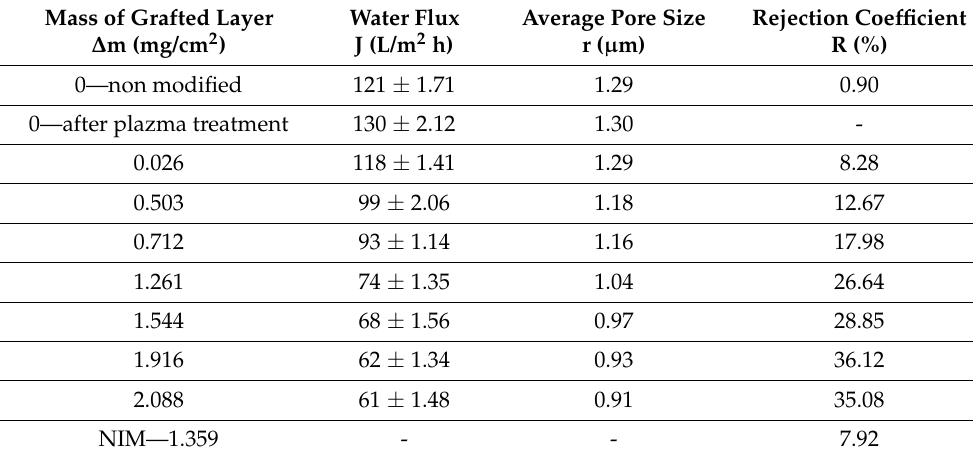
Table 8. Membrane filtration characteristic.